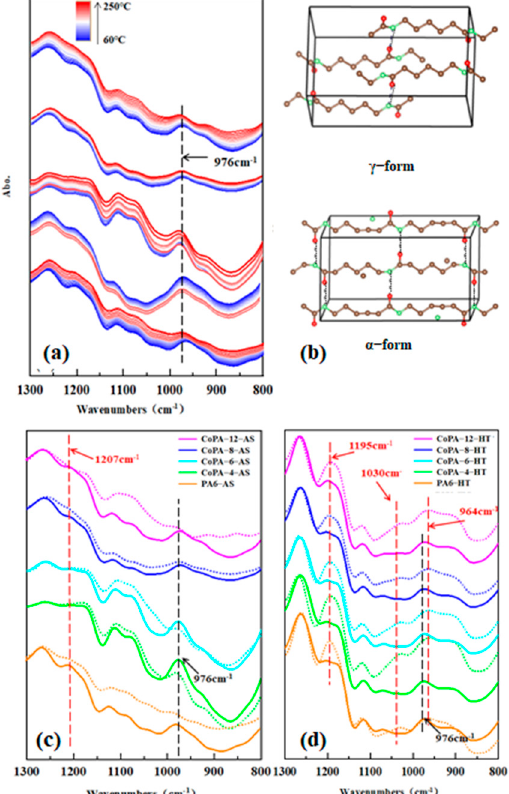
Figure 10. In − site ATR − FTIR spectra of PA6 and CoPAs AS fibers recorded from 60 °C (blue) to 220 °C (red) ( a ), at 60 °C (solid line) and 220 °C (dot line), the crystal structures of the α and γ crystalline forms ( b ) and AS fibers ( c ) vs. HT fibers ( d ) under wavenumbers varying from 1300 cm − 1 to 800 cm − 1 .